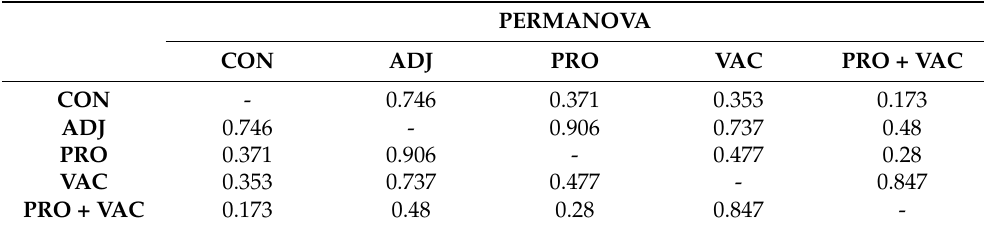
Figure 5. Principal coordinates analysis (PCoA) plots of the GI tract microbiota composition studied at the OTU level, from the Nile tilapia gut bacterial community (CON: control; ADJ: adjuvant; PRO: probiotics; VAC: vaccinated; PRO + VAC: probiotics + vaccine). Table 4. Permutational multivariate analysis (PERMANOVA) of OTU derived variance from gut bacterial communities of Nile tilapia. Tests were based on Bray–Curtis index dissimilarity distances and 999